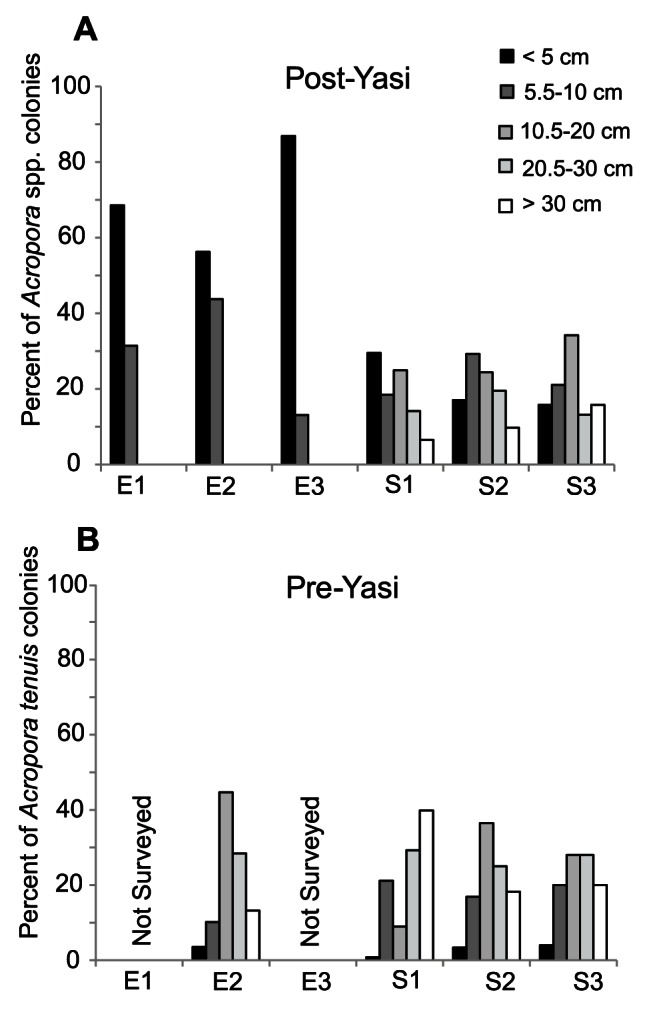
Size frequency distributions of colonies of Acropora in the Palm Islands.
A. Colony size frequency distributions for all species of Acropora at three exposed and three sheltered sites after cyclone Yasi (2011). B. Colony size frequency distributions of Acropora tenuis at one exposed and three sheltered sites before cyclone Yasi (2010).